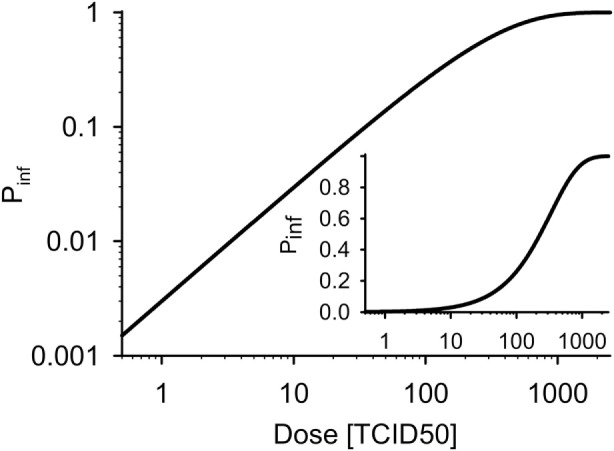
Dose–response curves for wild boar (PTCID50 = 0.003). Inset: linear ordinate.